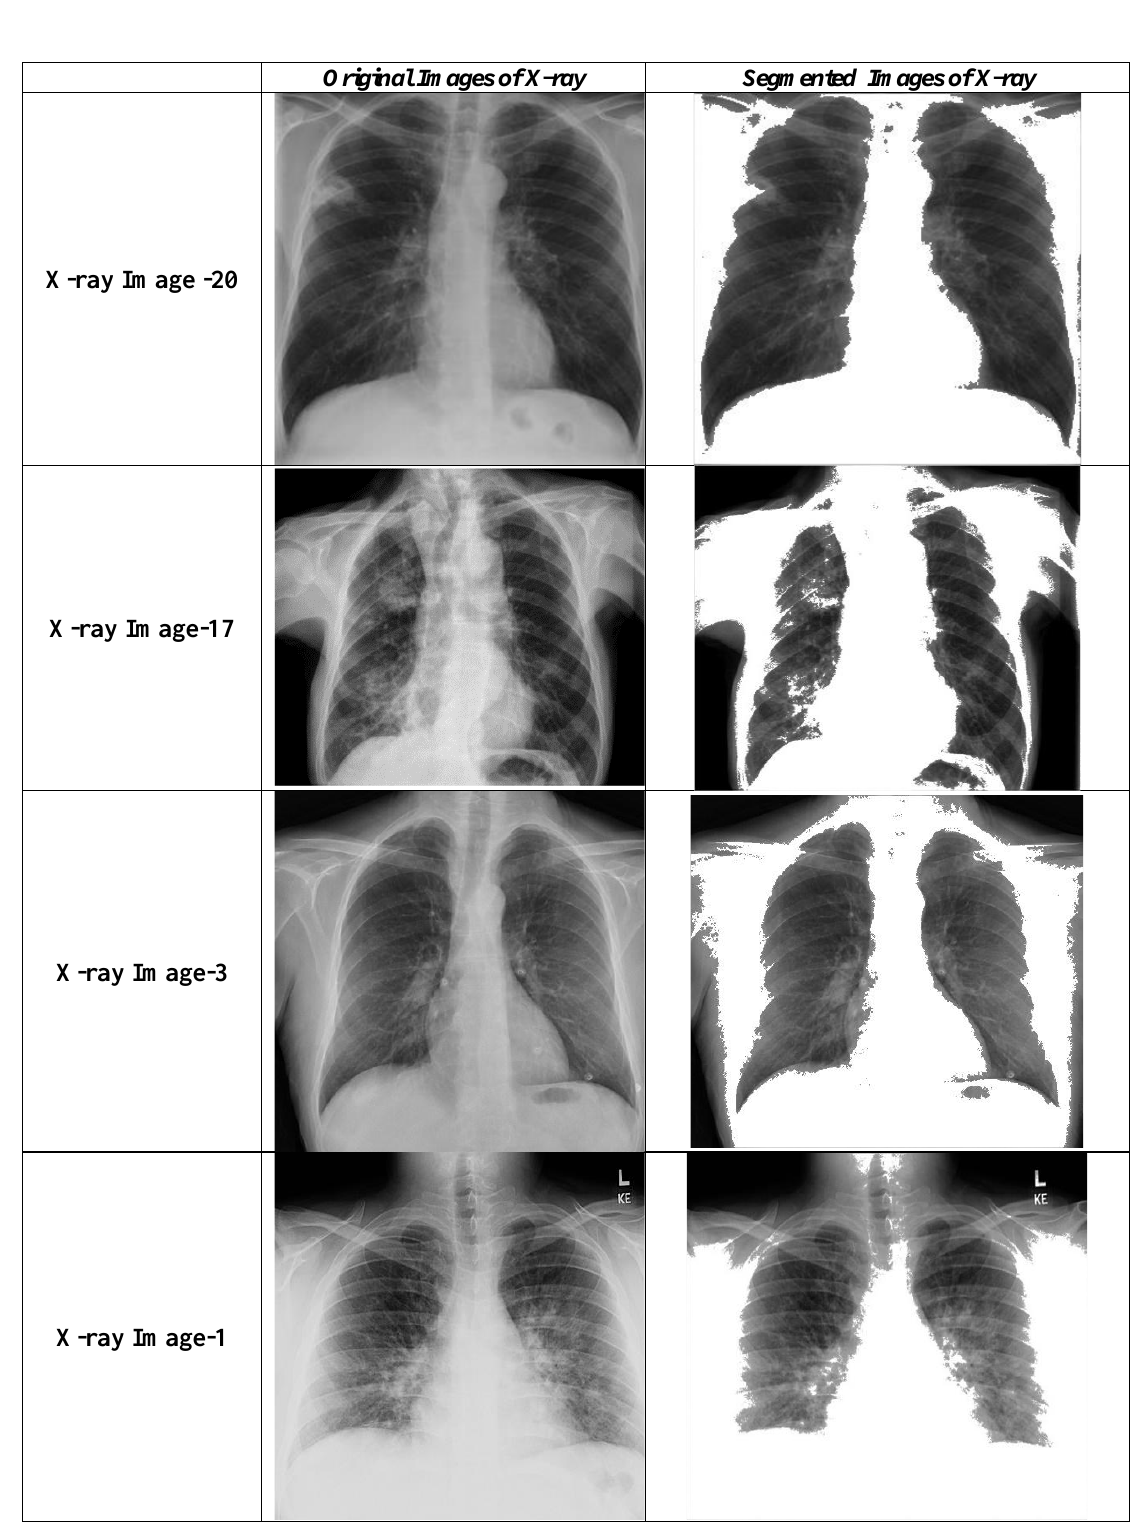
Figure 4. Original and the segmented lung